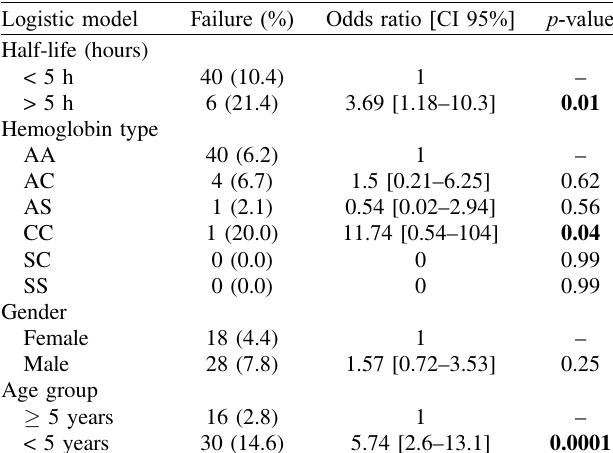
Table 4. Multivariate analysis of risk factors associated with the occurrence of treatment failures.